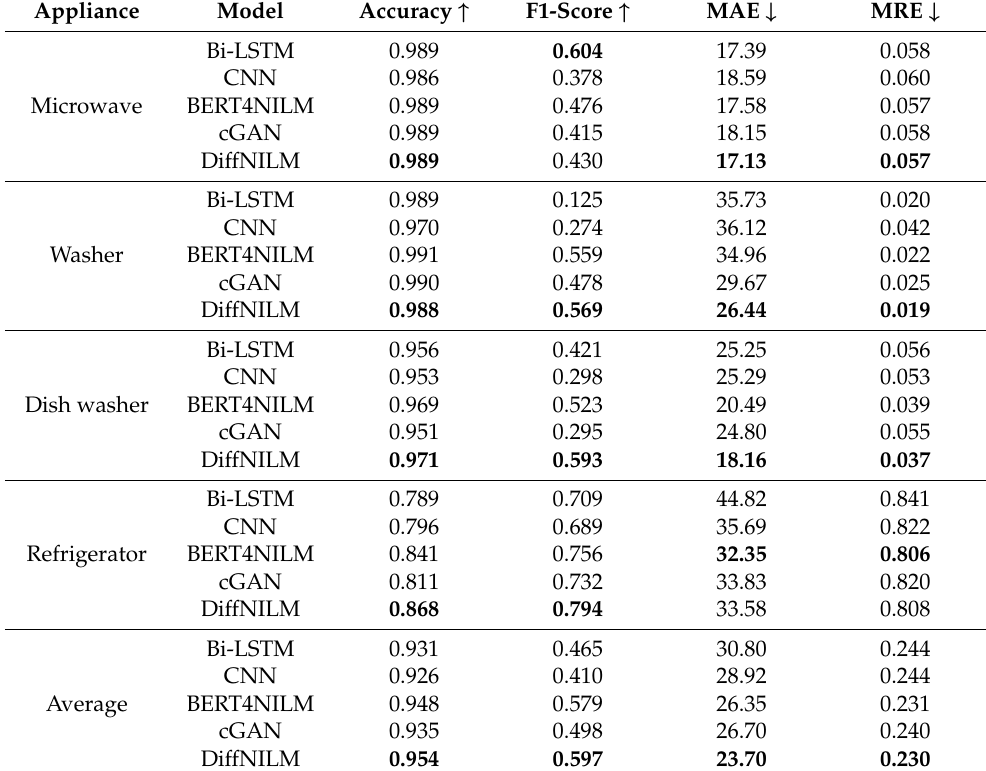
Table 3. Model performances on